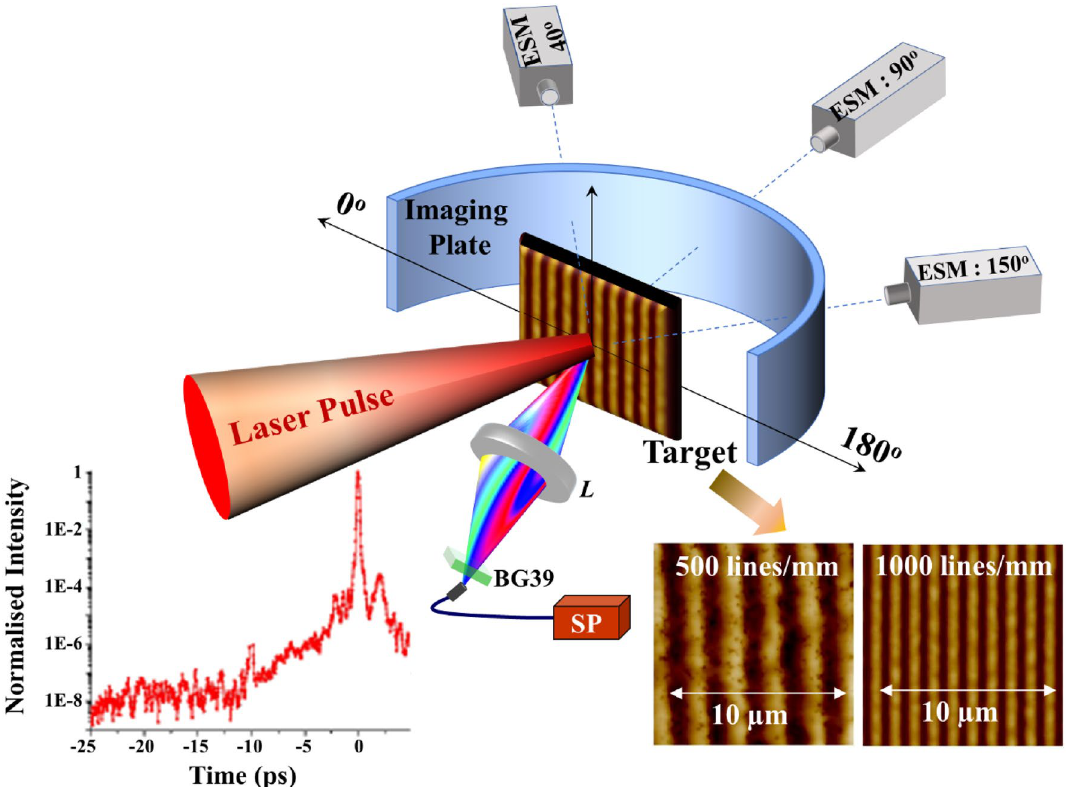
Figure 1. Schematic of the experimental setup. The angle of incident of interaction laser (40°) is maintained for Gr500, Gr1000, and plane Au foil. Image plate (covered with appropriate thickness of aluminium filter) is placed behind the target to measure electron angular distribution. The energies of fast electrons emerging at target rear are measured by independent electron spectrometers located along three different directions to the target (40°, 90°, and 150°). The interaction laser contrast (bottom left) and atomic field microscopic (AFM) images of the grating targets (bottom right). Plasma emission is measured at the front side of the target at specular direction. L : Lens, BG39: A Schott BG-39 filter, SP: